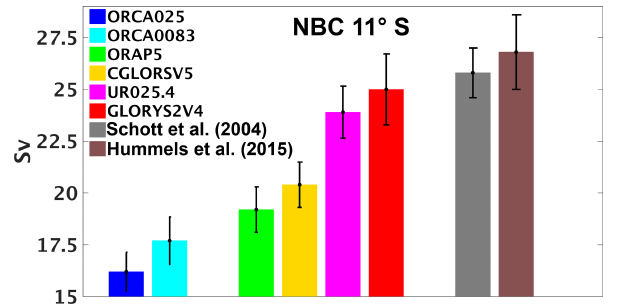
Figure 5. The NBC transports (1997–2010) at 11 ◦ S calculated be- tween the surface and the neutral density interface of 27.7kgm − 3 using the same section near the western boundary and methodology as in Hummels et al. (2015). The black bars represent the standard errors for which the size of the sample is defined as the length of the monthly time series. Units are